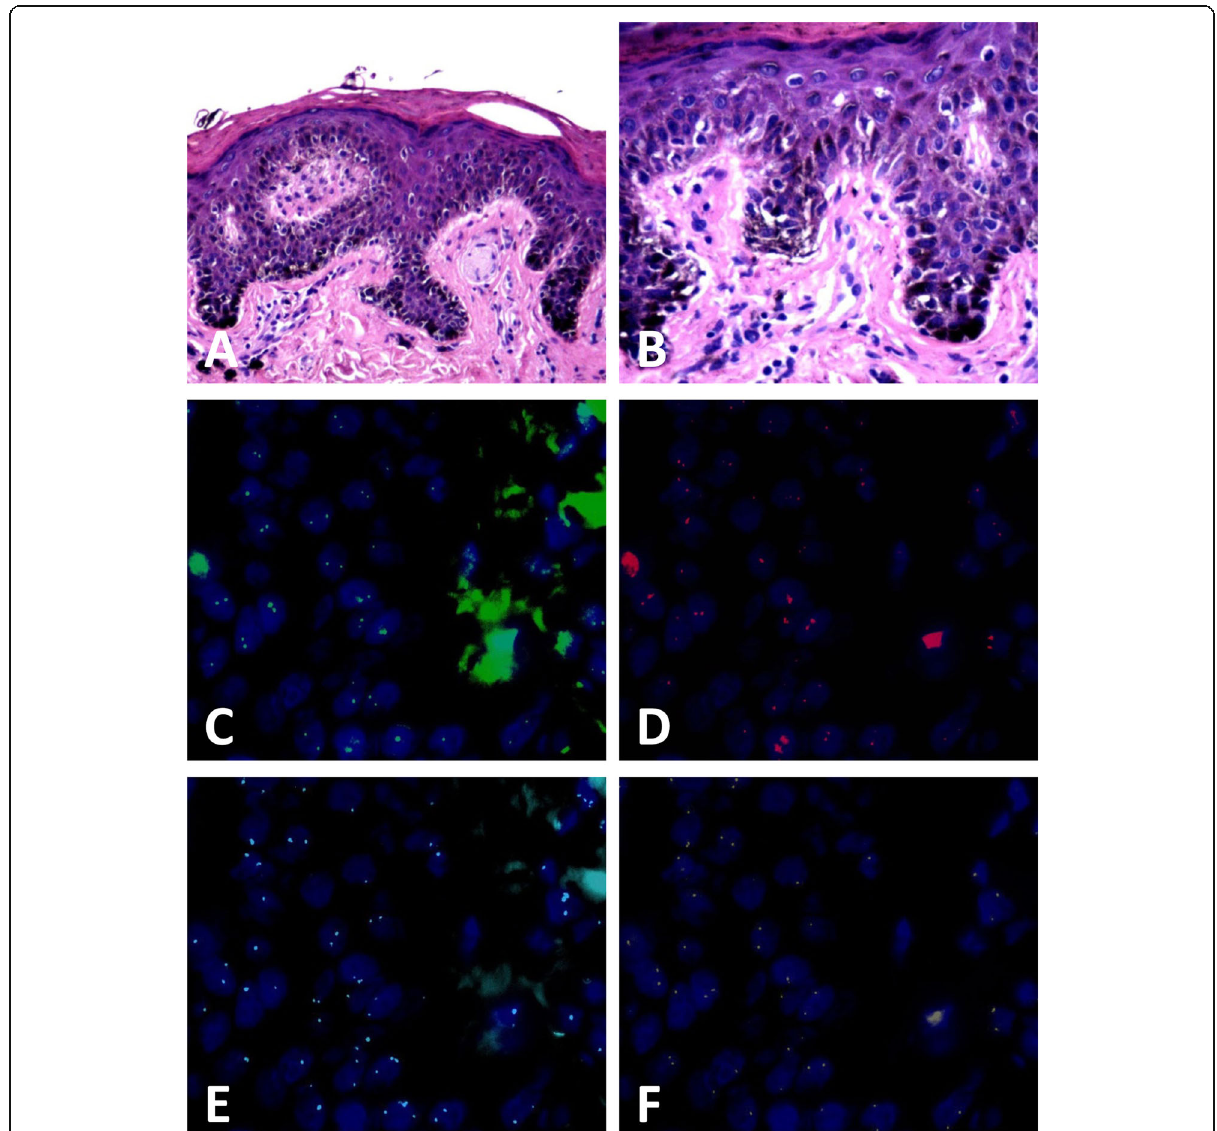
Fig. 2 Case of dysplastic junctional nevus negative by fluorescenc e in-situ hybridization (FISH) detection. a Melanocytes proliferated successively or scattered in the basal layer of the epidermis (hematoxylin and eosin, H&E staining), ( b )high-power magnification showed mild atypia of the melanocytes(H&E staining), ( c-f ) FISH images showed normal copies of CCND1 ( c , green signals), RREB1 ( d , red signals), CEP6 ( e , aqua signals), and MYB ( f , gold